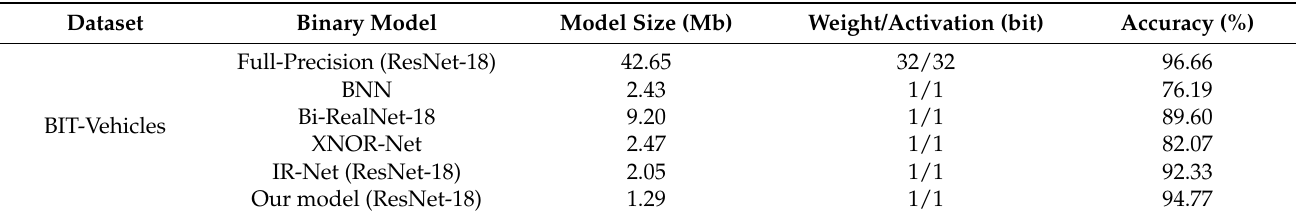
Table 4. Comparison with classical binarization model.